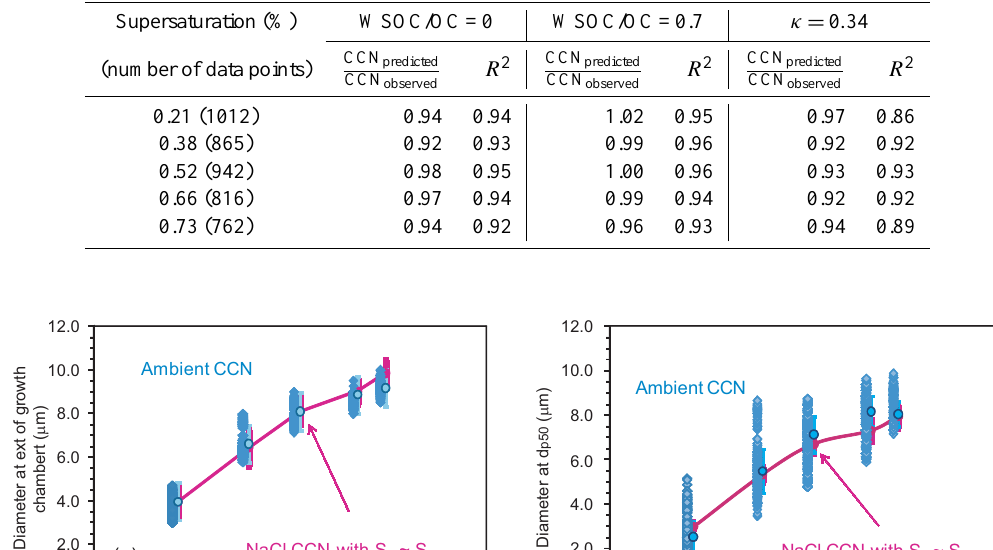
Table 2. Regression statistics for the CCN closure.